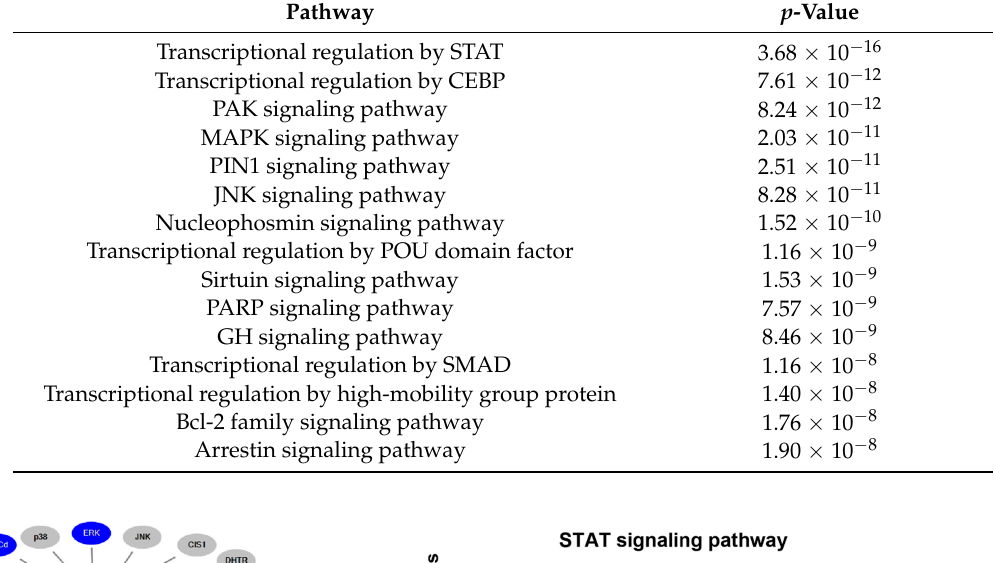
Table 3. The top 15 pathways were specifically regulated by GTE’s preventive administration in obese zebrafish ( p < 0.05).